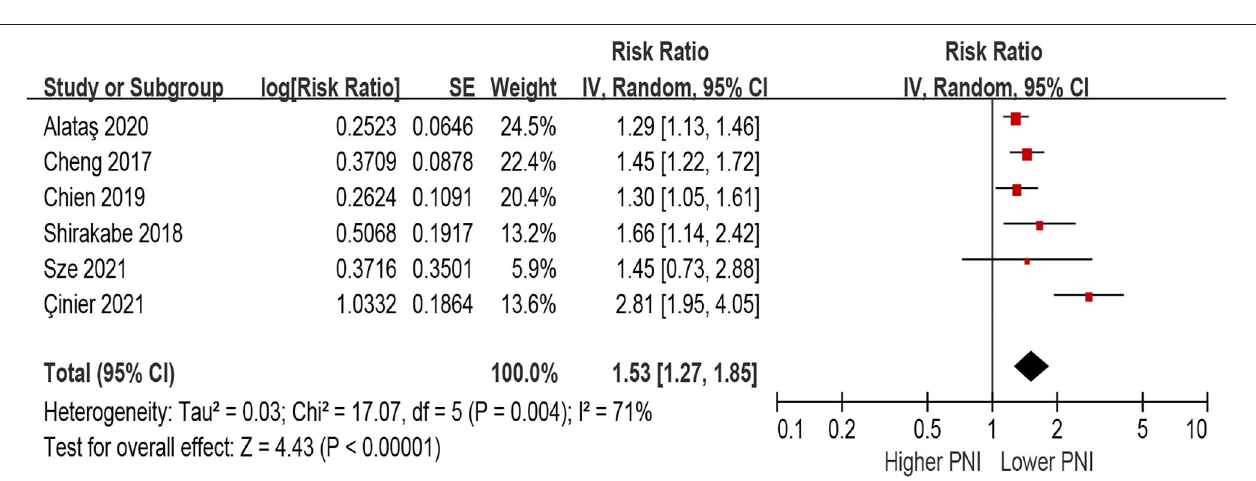
FIGURE 3 | The association between PNI (defined as lower vs. higher) and the risk of all-cause mortality in HF (multivariable-adjusted model). CI, confidence interval; HF, heart failure; PNI, prognostic nutritional